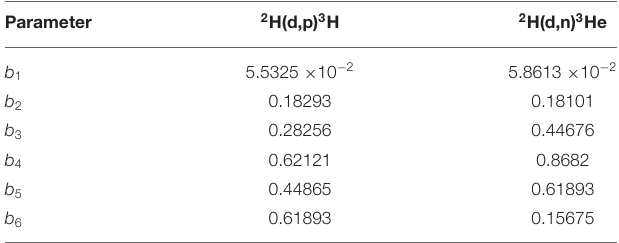
TABLE 1 | Fit parameters for the S-factors of the reactions 2 H(d,p) 3 H and 2 H(d,n) 3 He measured in TH experiments using Equation (6).